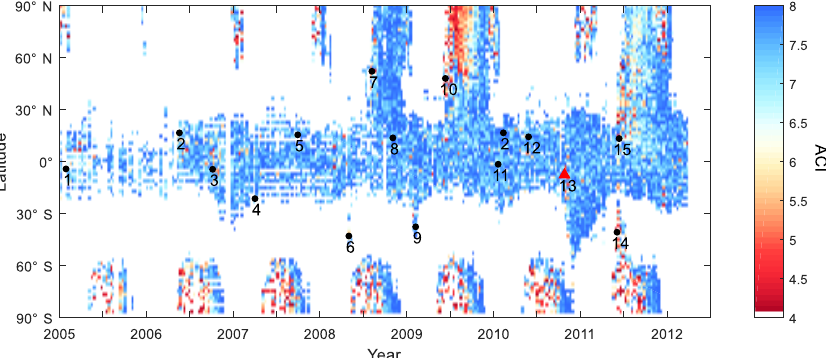
Figure 5. Median of MIPAS ACI values between 12 and 18km (bin size 10 days and 2 ◦ in latitude) from January 2005 to April 2012. Only ACI values from 4 to 8 are shown. The red triangle indicates the eruption of Mount Merapi (13). The black filled circles indicate (1) Manam, (2) Soufriere Hills, (3) Tavurvur (Rabaul), (4) Piton de la Fournaise, (5) Jebel at Tair, (6) Chaitén, (7) Kasatochi, (8) Dalaffilla, (9) Australian bushfire, (10) Sarychev Peak, (11) Nyamuragira, (12) Pacaya, (14) Puyehue-Cordón Caulle and (15)